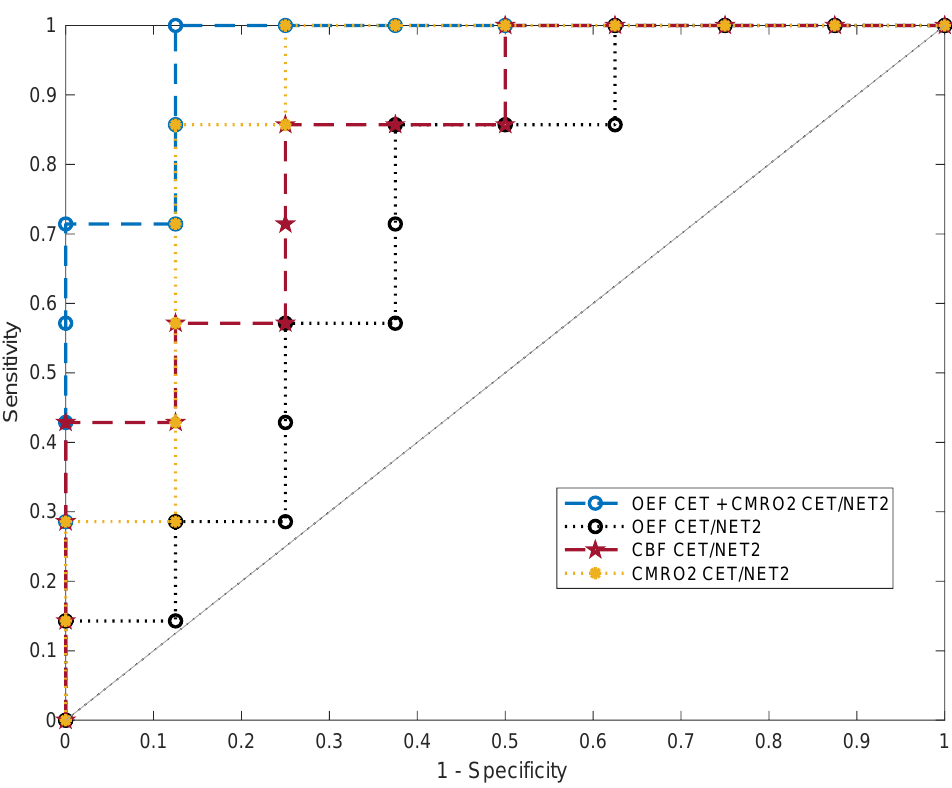
Figure 5. Five-fold cross-validated ROC curves for the support-vector machine classifier predicting binary outcome (GBM or cMET). Curves are shown for the ratios of oxygen extraction fraction (OEF CET/NET2 ), cerebral blood flow (CBF CET/NET2 ) and cerebral metabolic rate of oxygen (CMRO 2 CET/NET2 ) in contrast-enhancing tumor (CET) divided by peritumoral non-enhancing T2 FLAIR hyperintensity (NET2) as well as for the multivariable fit to OEF CET and CMRO 2 CET/NET2 . OEF CET : OEF in contrast-enhancing tumor.